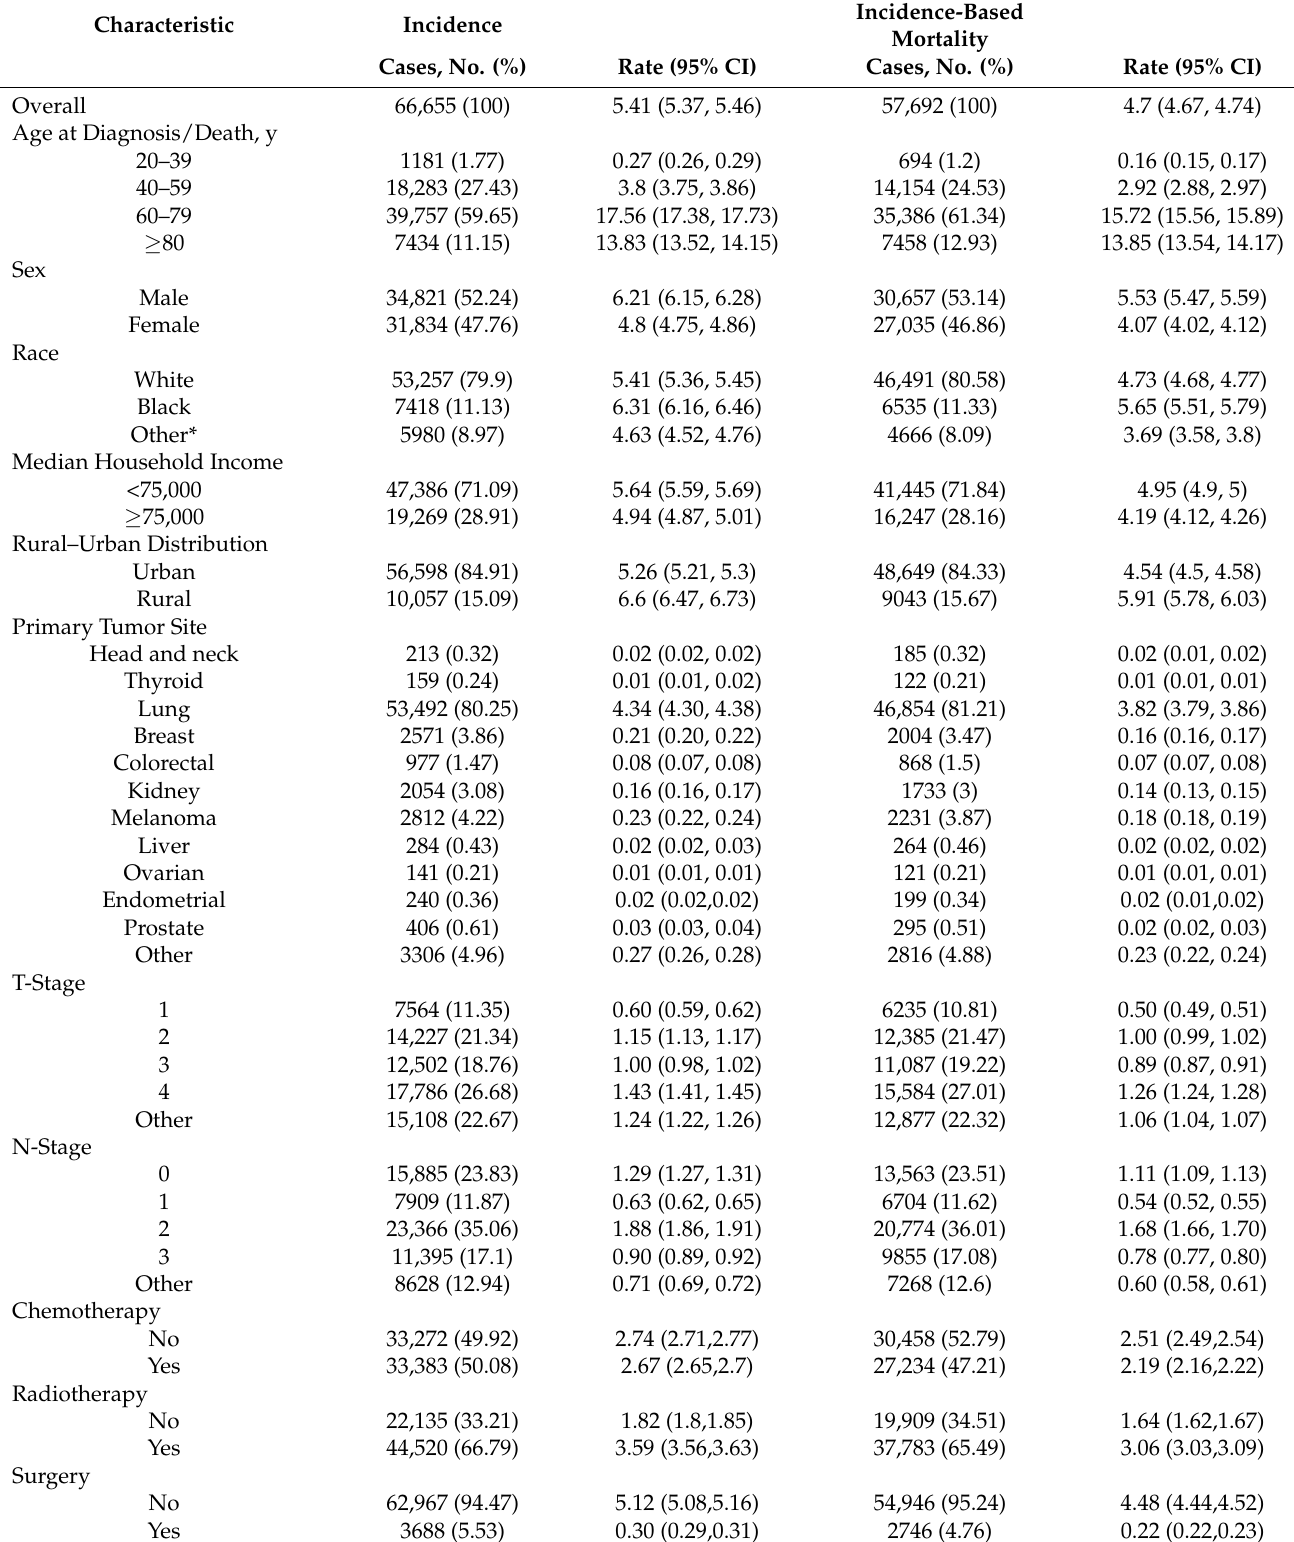
Table 1. SBM* incidence and incidence-based mortality (2010–2019): the SEER-17registry